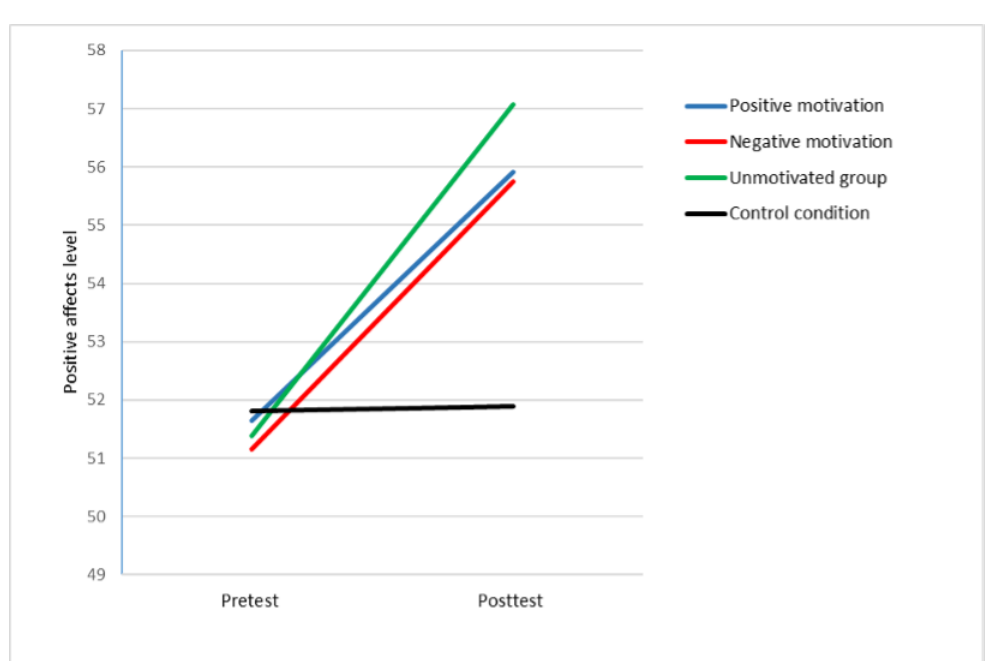
Figure 1. The positive affect mean scores in pretest and posttest of the four groups of students: positively motivated (PM)*, negatively motivated (NM)*, unmotivated group (UM)*, control conditions (CC). Significant differences between control groups and experimental groups in posttest (p < 0.001). * Intra-group differences significant at the level of p